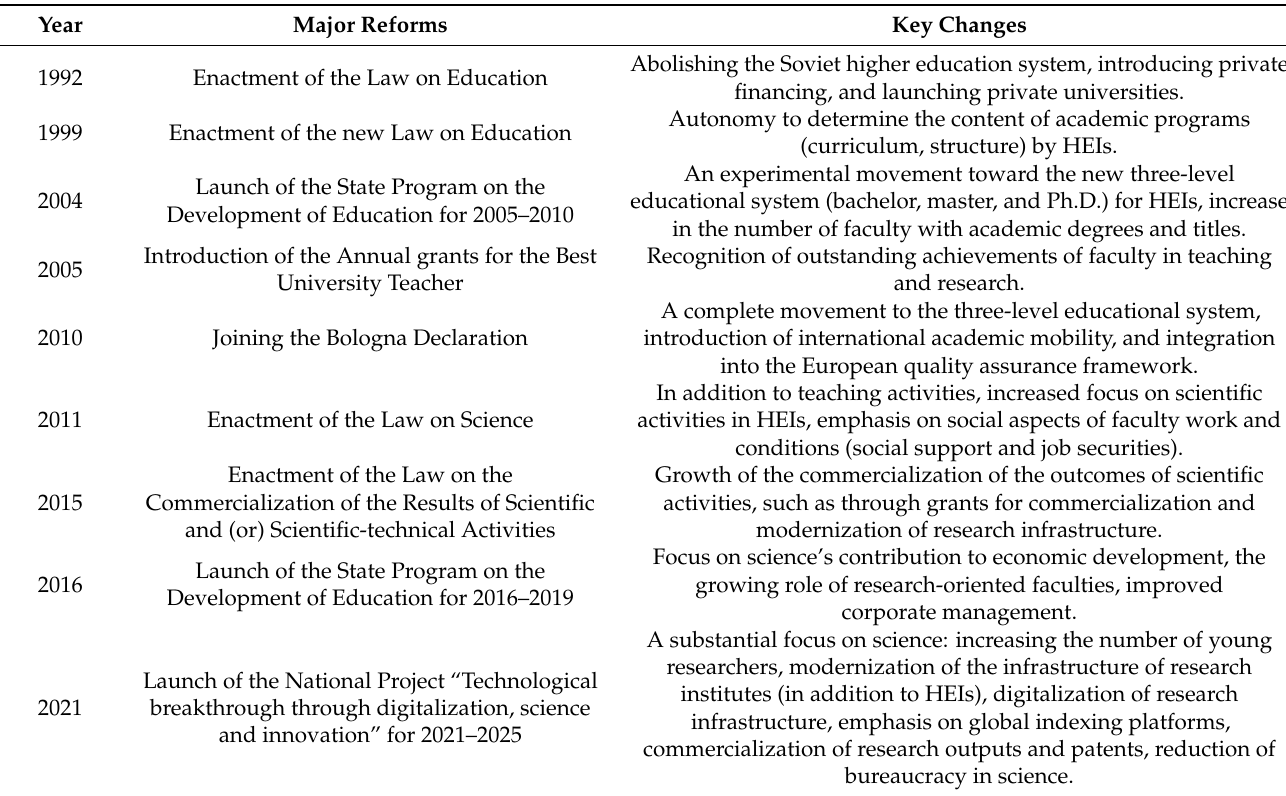
Table 2. Major reforms in education and science in Kazakhstan.